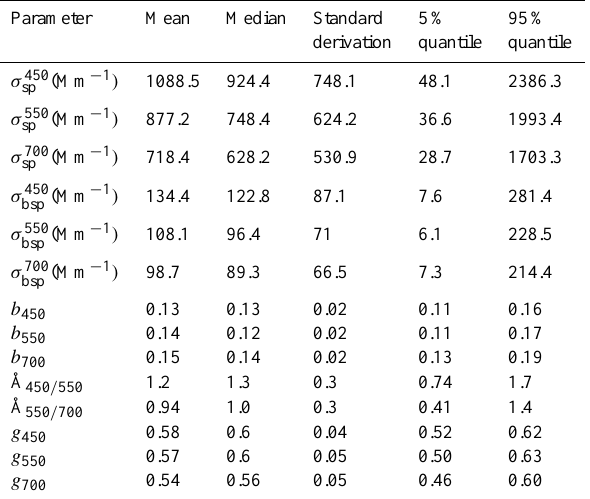
Table 1. The statistic of aerosol optical properties during the obser- vation period.